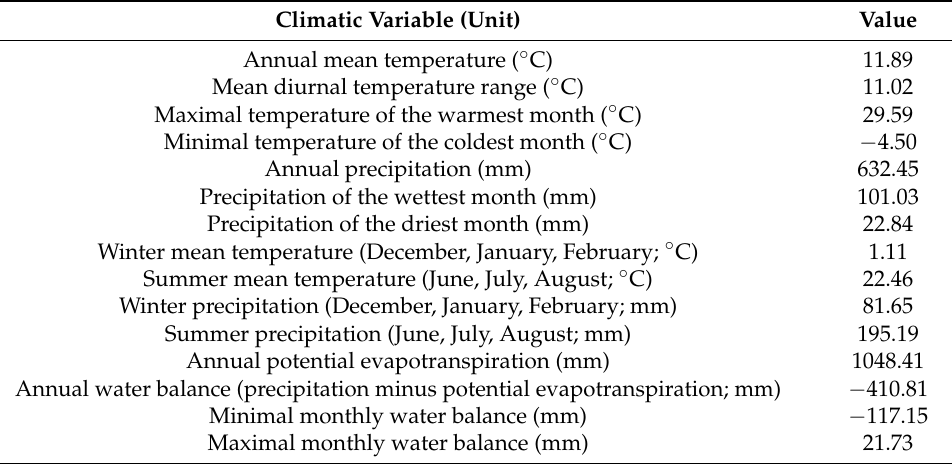
Table 1. Bioclimatic characteristics of the study site in Jighaura (eastern Georgia) according to the EuMedClim database